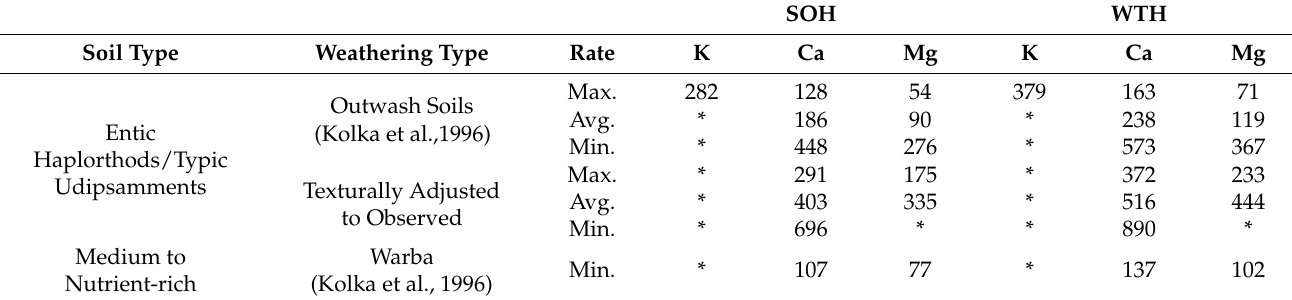
Table 3. Recovery time in years for weathering and deposition inputs to replace outputs of a single harvest and leaching by harvest type. The number of recovery years demonstrates that the inputs do not replace outputs at current rotation lengths, besides K and Mg in the non-texture-adjusted ceiling and average of the maximum weathering rates. * indicates the weathering rates and deposition do not exceed the outputs indicating that the harvest nutrient pool is not